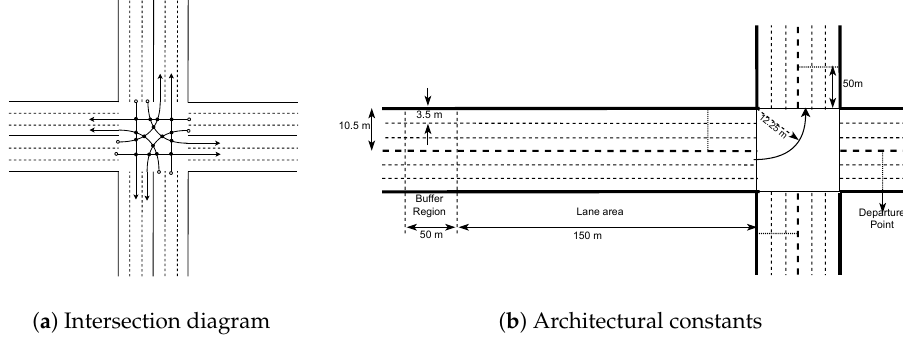
Figure 2. Intersection model and architectural